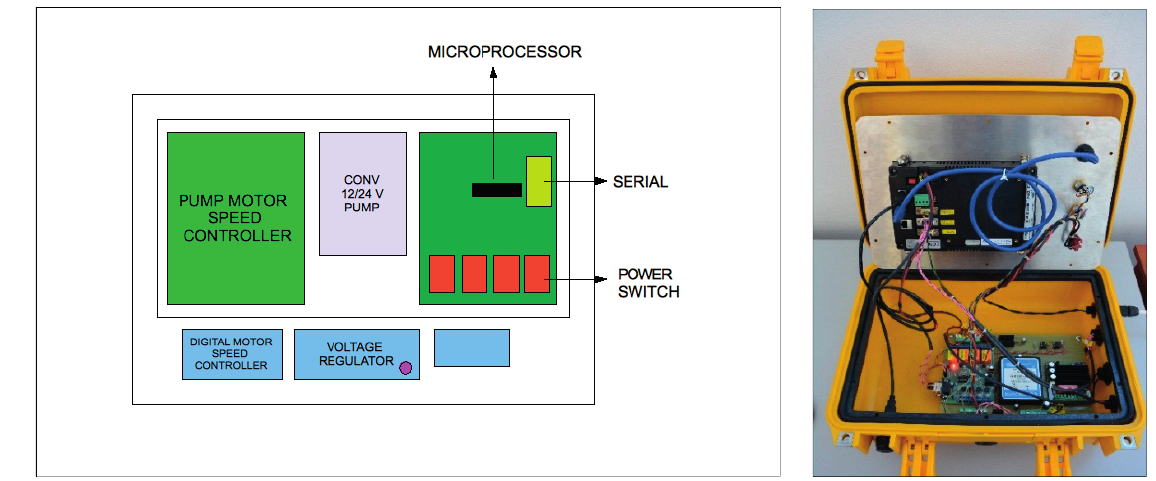
Figure 13. The control unit: The scheme ( Left ) and the realized prototype ( Right ).